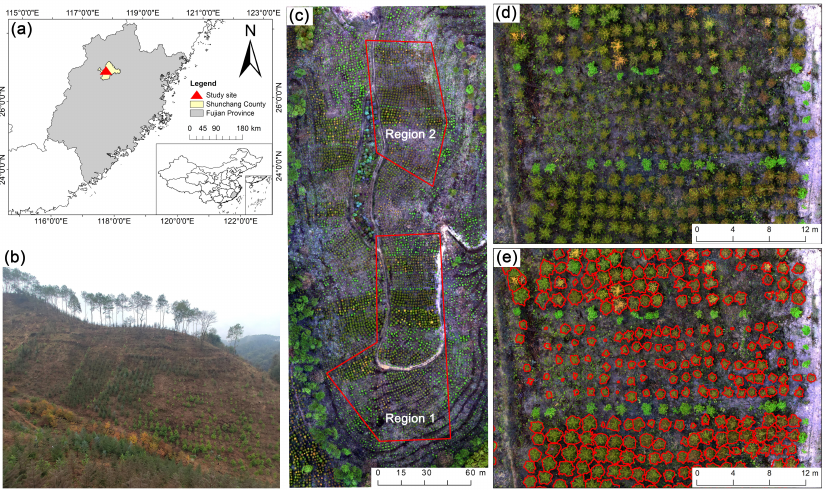
Figure 1. Experimental site: ( a ) Location of the study site (the red triangle marks the study site in Shunchang County, Fujian Province); ( b ) Field photo; ( c ) UAV imagery, showing region 1 and region 2 that highlight regions with field survey data; ( d ) Example of UAV image in the study area, shown with RGB bands; ( e ) Example of manually delineated Chinese fir tree crowns (in red), and broad-leaved trees without red